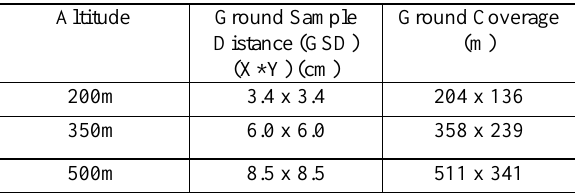
Table 1. Data description in Tongyeong